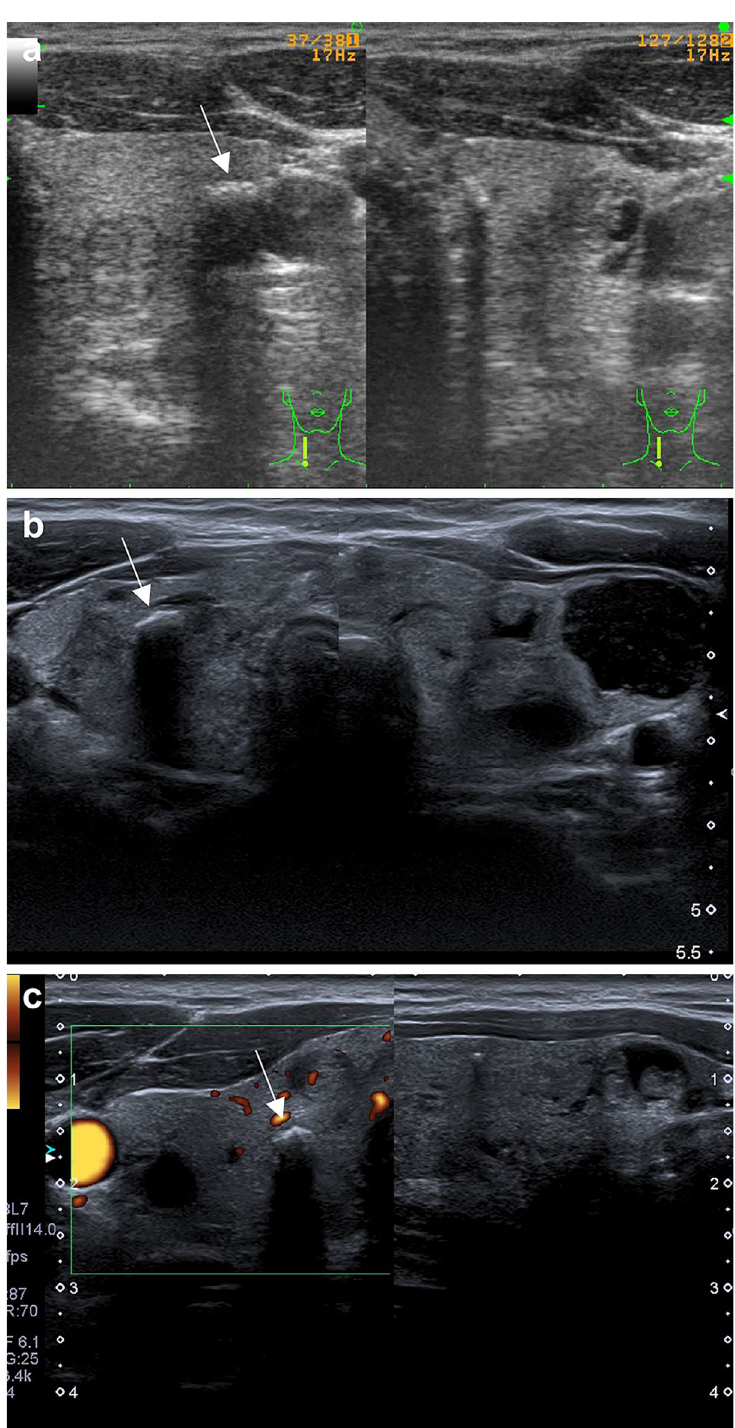
Figure 2. (a–c) Ultrasonographic presentation of MNG in DICER1 mut+ adult patients. A classic image of MNG for DICER1 syndrome; macrocalcifications were also observed (marked with white